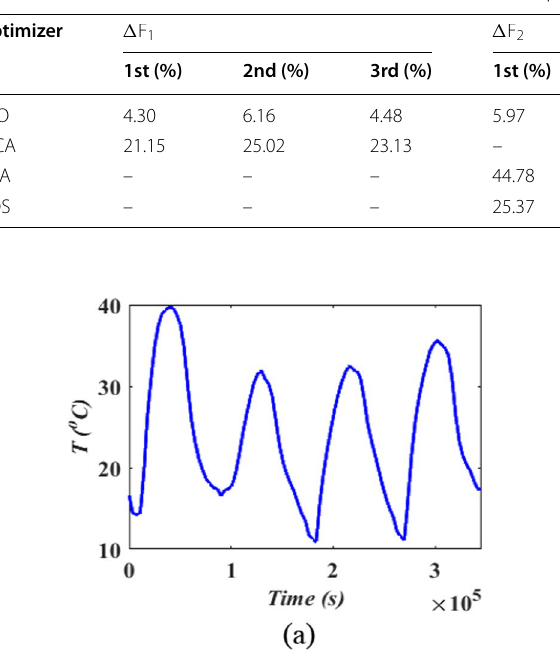
Table 4 Reductions in (cid:31) F 1 , (cid:31) F 2 and (cid:31) P 12 deviations due to 3 step load changes using COA